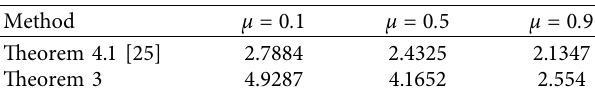
� 1 and various for d 2 1